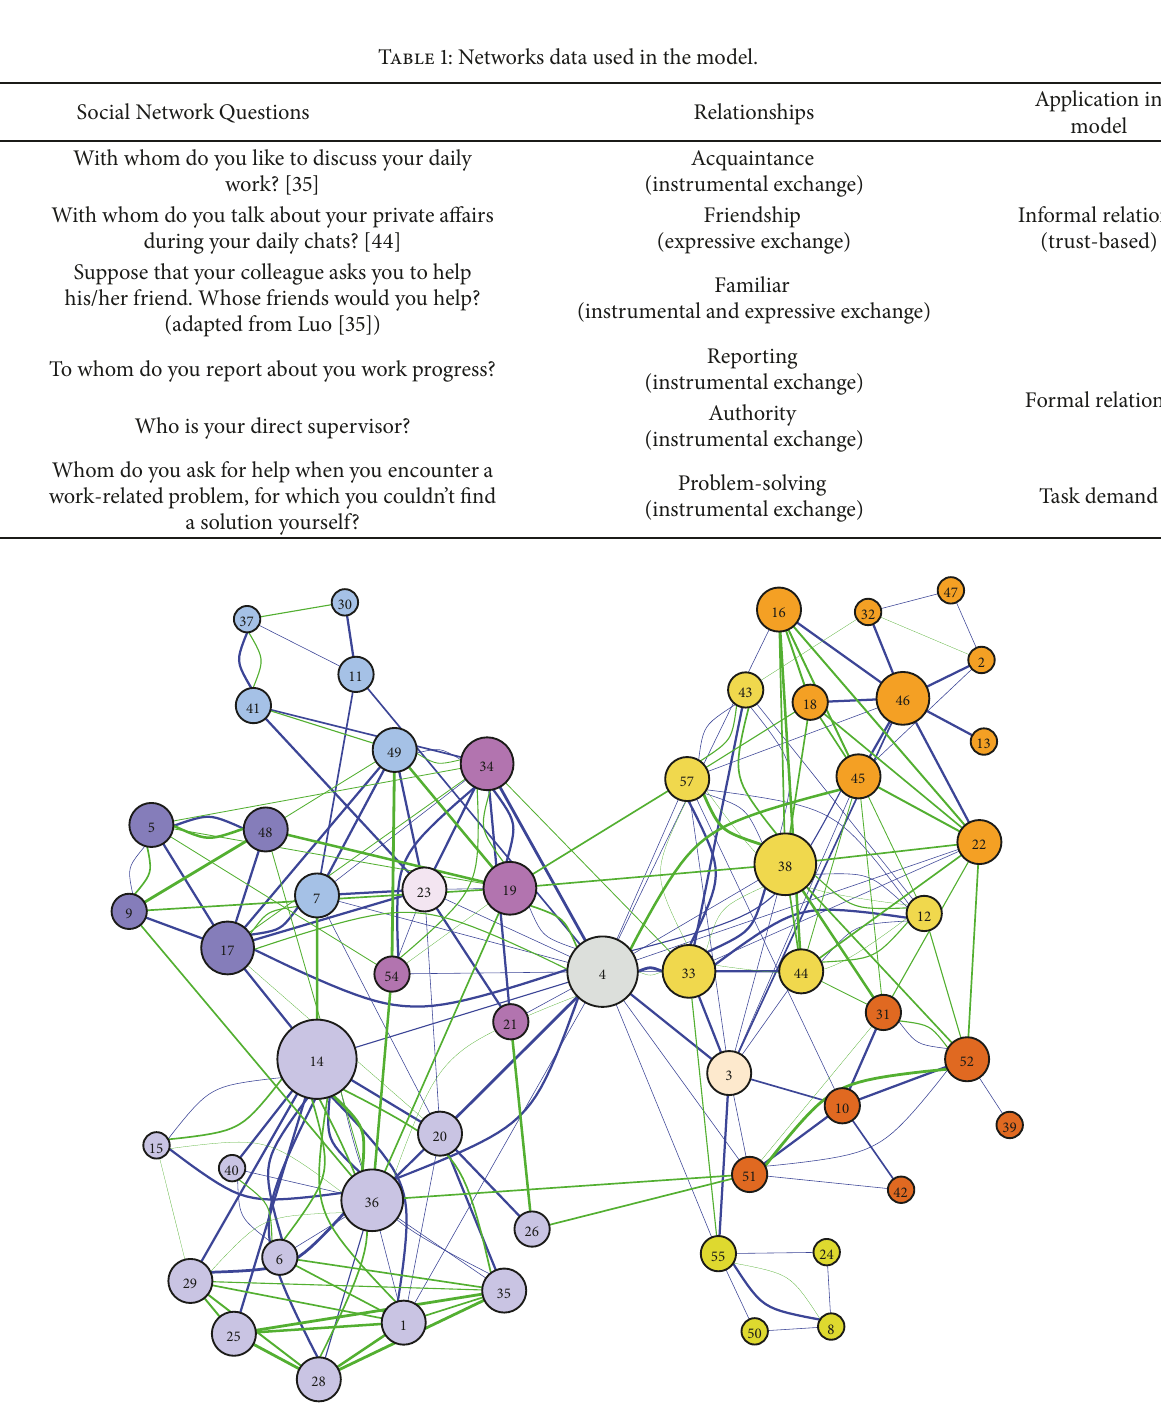
Figure 3: Multiplex model of organisational interdependencies. Nodes’ colours represent work units. Node size depicts node strength. Blue and green edges are formal and informal relations. Individual no. 4 works in both